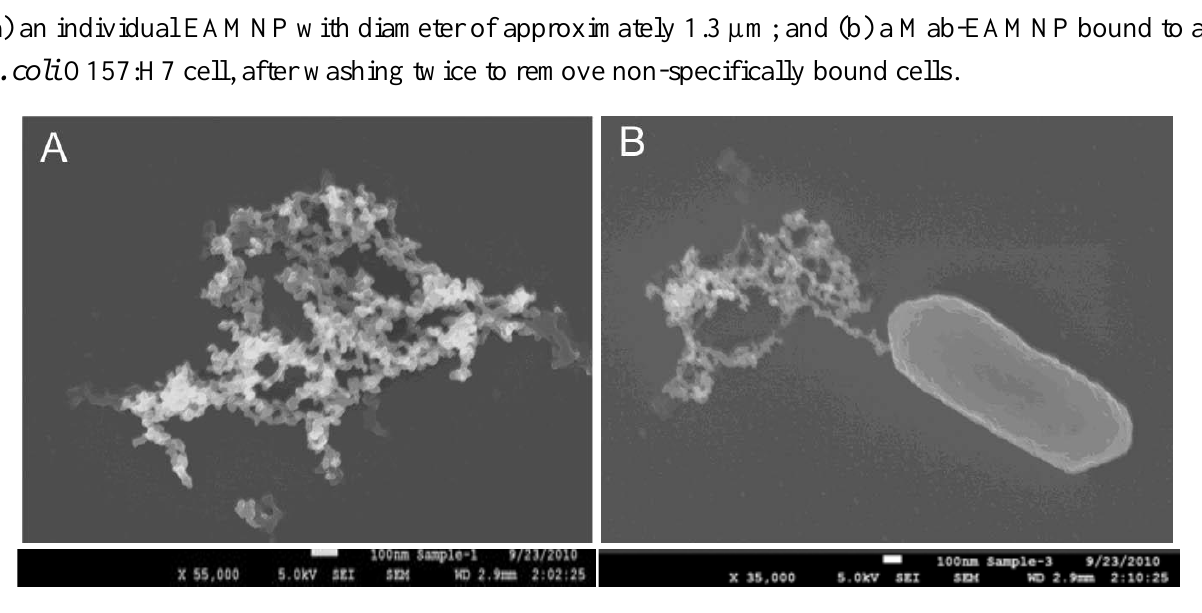
Figure 2. Scanning electron micrograph of ( a ) an individual EAMNP with diameter of approximately 1.3 µm; and ( b ) Mab-EAMNP bound to an E. coli O157:H7